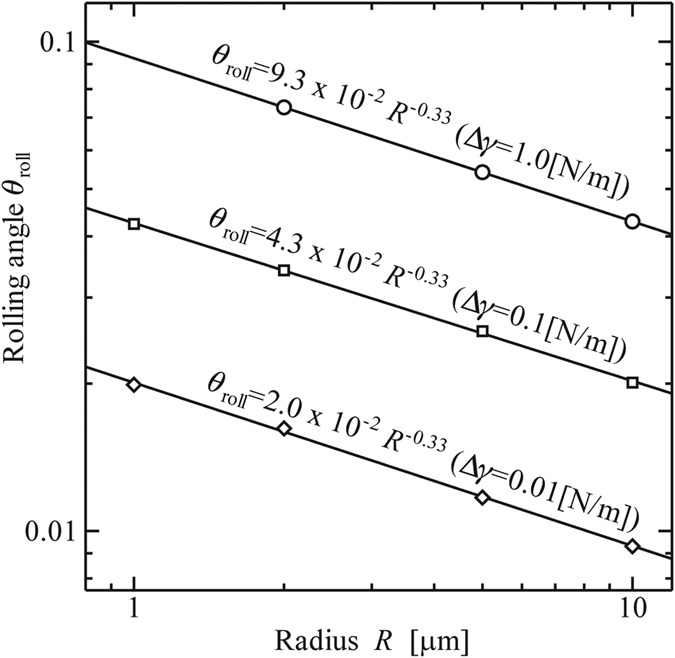
Rotational angle at the beginning of rolling, θroll [rad].(Material: polystyrene, E = 3.8 [GPa], ν = 0.34).